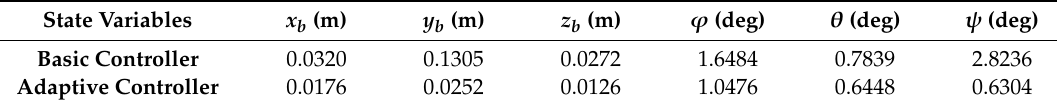
Figure 13. System responses in Scenario 1. Table 3. Root mean square error (RMSE) of Scenario 1.